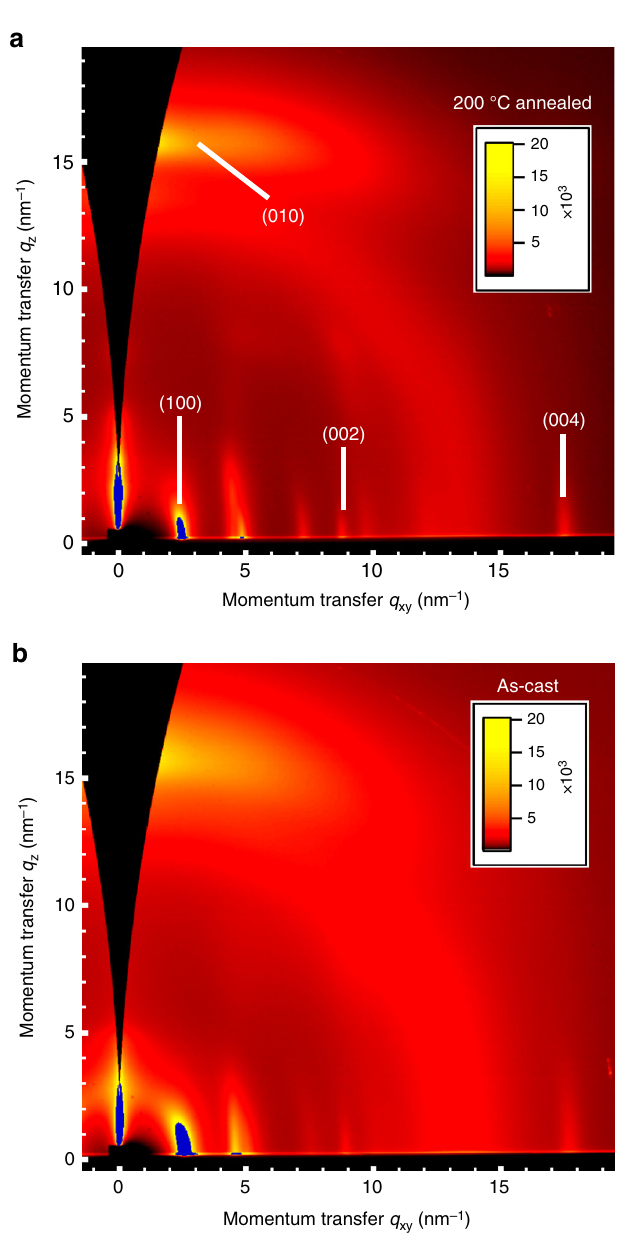
Fig. 2 2D grazing incidence scattering patterns of P(NDI2OD-T2) polymer fi lms. The GIWAXS patterns for the 200 °C annealed fi lm ( a ) and the as- cast fi lm ( b ) are shown. The peak assignments are based on previous reports 48,49 . From the diffraction peaks an increase in coherence length in all directions upon annealing is evident. This indicates an increase in the average volume of crystalline domains by a factor of 4 and the average lamellar area (relevant for charge transport in OFETs) by a factor of